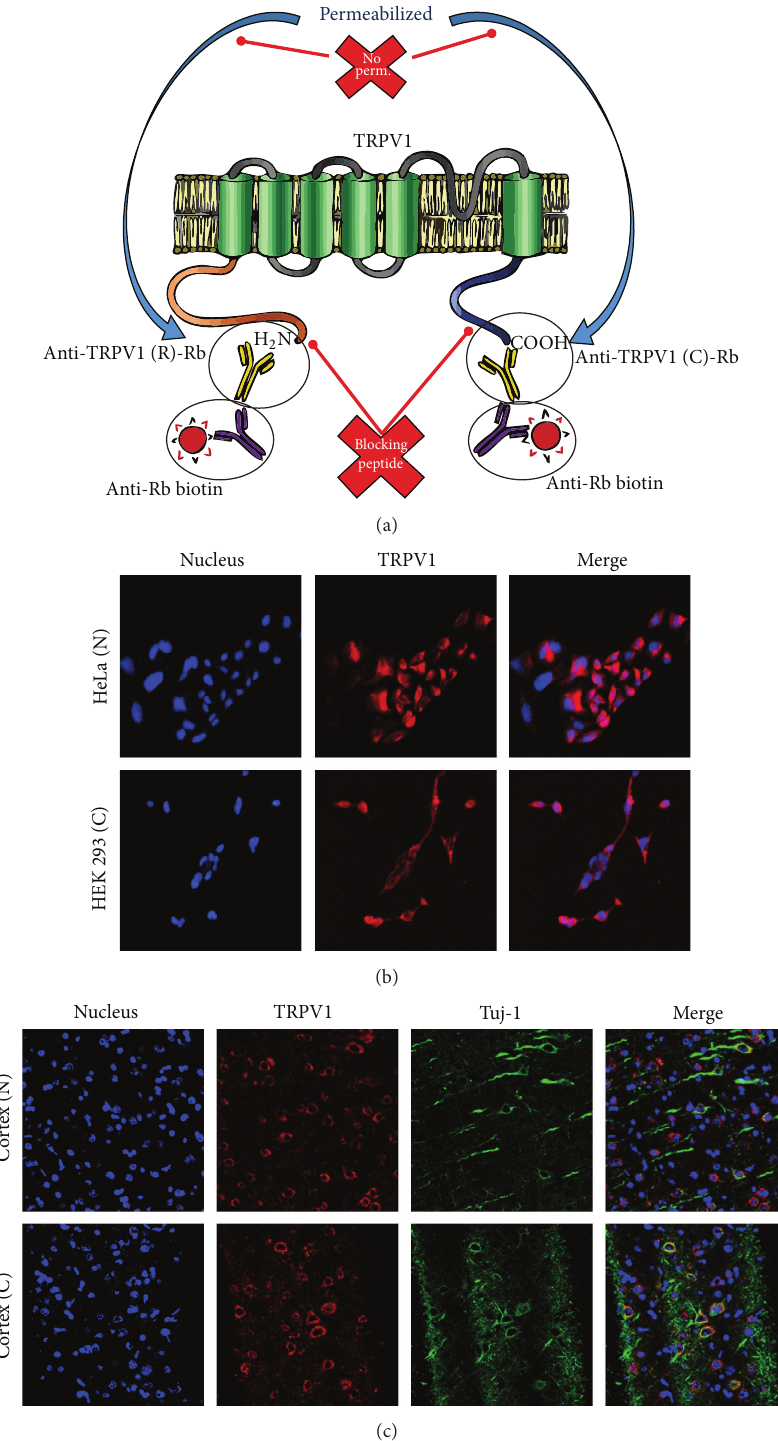
Figure 2: TRPV1 detected by immunofluorescence. (a) Methodology proposed for detection of TRPV1 by immunofluorescence. Using two antibodies against different epitopes of the channel allows corroborating the expression of the channel. In this case, we showed an antibody against the C-terminal and another against the N-terminal. As both antibodies bind to intracellular epitopes, it is advisable to use as internal control of the technique a sample without permeabilization of the plasma membrane, which prevents the entry of the antibody into the cell. One added strategy to improve signal sensitivity was the use of a blocking peptide, in this case, for the C-terminal or N-terminal. The competition of the blocking peptide with the epitope of the channel should diminish the intensity of the signal indicating the specificity of the technique. (b) Detection of TRPV1 in heterologous expression system using antibodies against the N-terminal and C-terminal of TRPV1. (c) Detection of TRPV1 in primate prefrontal cortex, using an antibody against the N-terminal and another against the